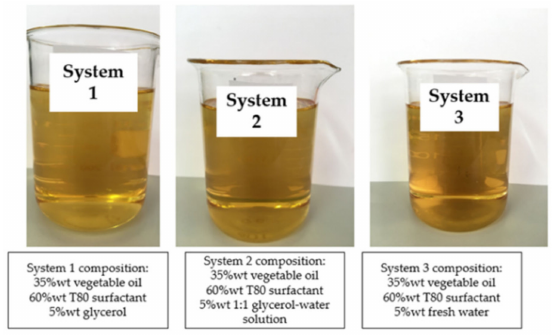
Figure 4. Microemulsion samples of the systems 1, 2 and 3.